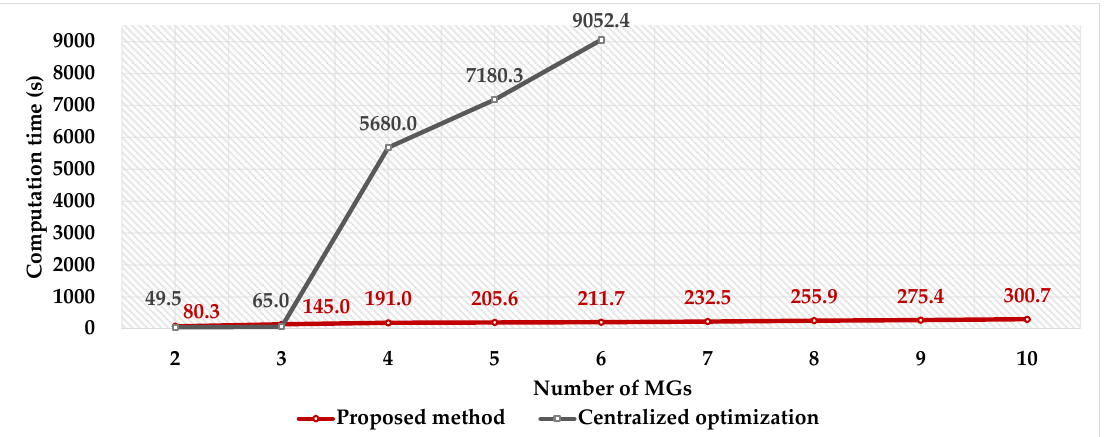
Figure 12. Computation time of the two power sharing scheduling methods according to the number of MGs.